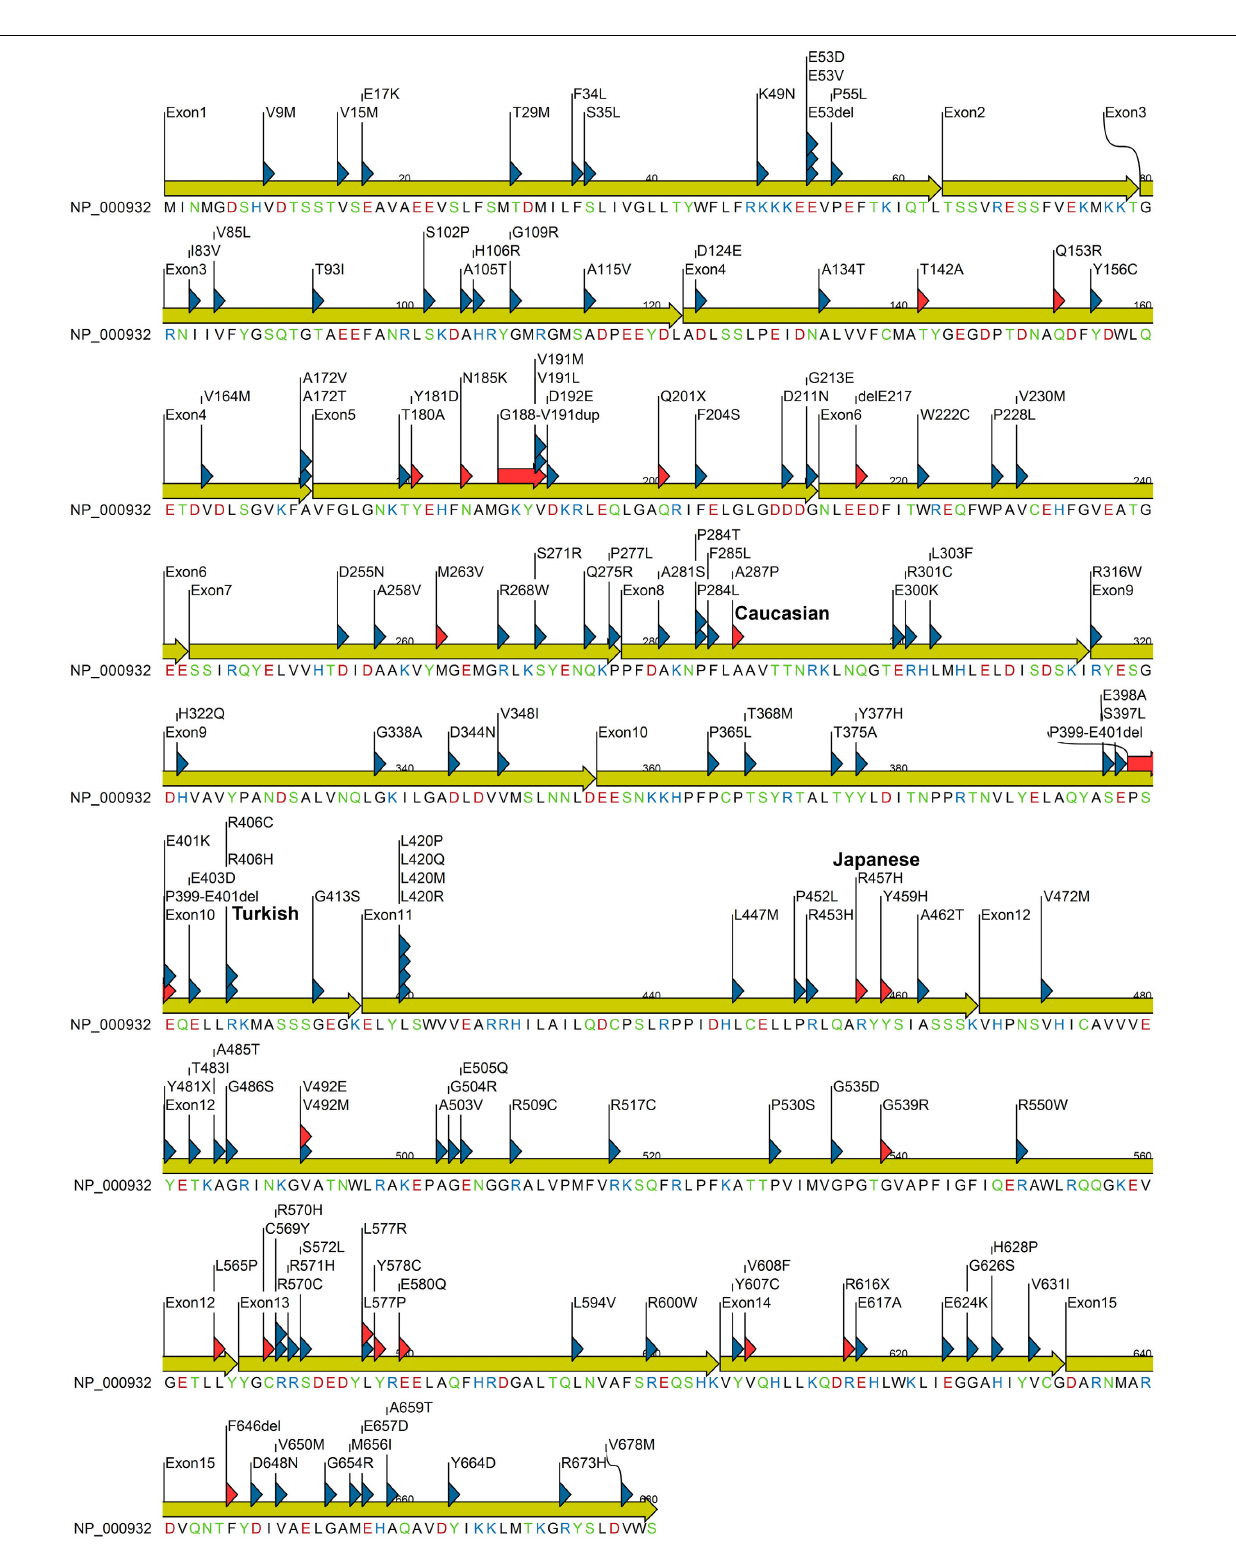
FIGURE 4 | PORproteinsequenceshowingmissensemutationsidentified in patients and variations from normal human population. Mutation found in patients are indicated with red triangle while variants identified from healthy individuals are indicated with blue triangle. Amino acids are colored based on